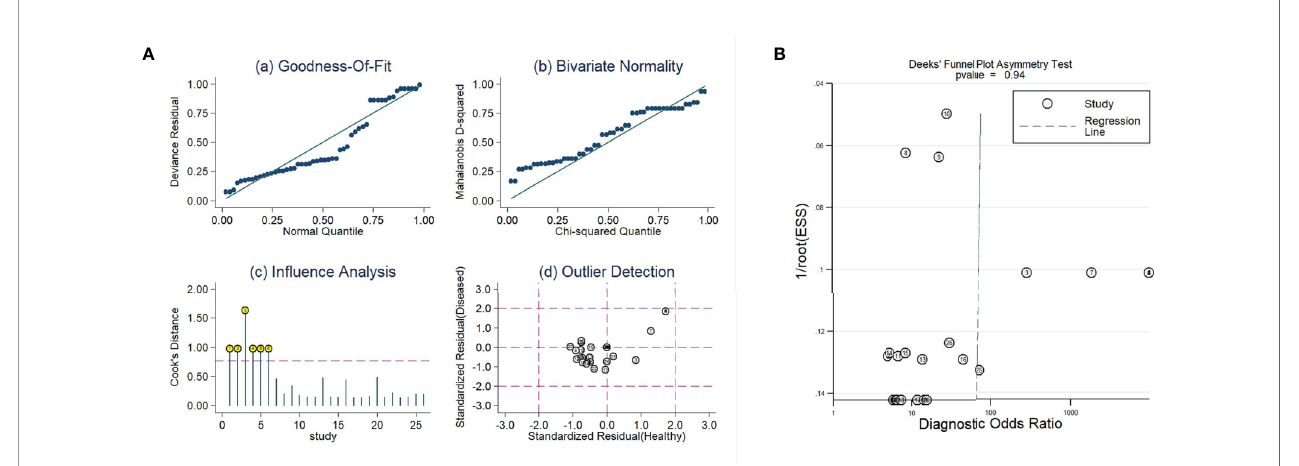
FIGURE 6 | The sensitivity analysis (A) and Deeks ’ funnel plot asymmetry test (B) of